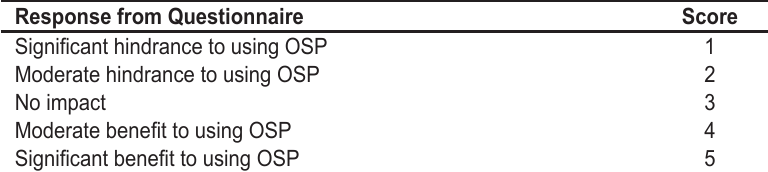
Table 2: Scores used to allocate points against responses from the questionnaire